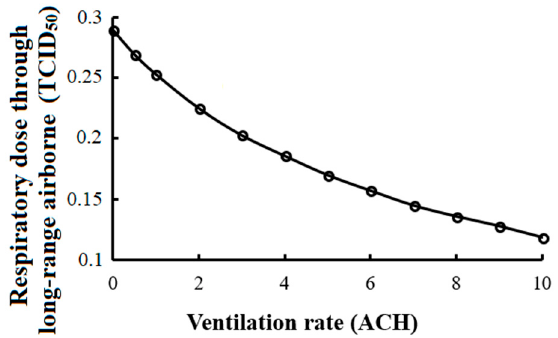
Figure 7. Respiratory dose via the long ‐ range airborne route at various ventilation rates.